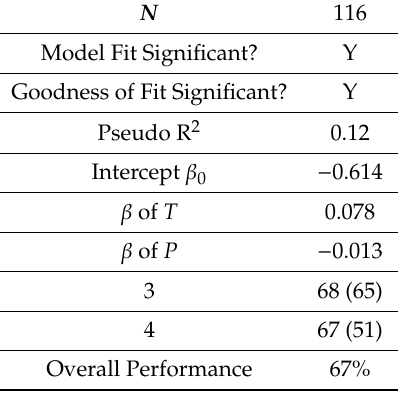
Table 7. MLR modelling results for Log FC y,m with only classes 3 and 4 and variables, T and P